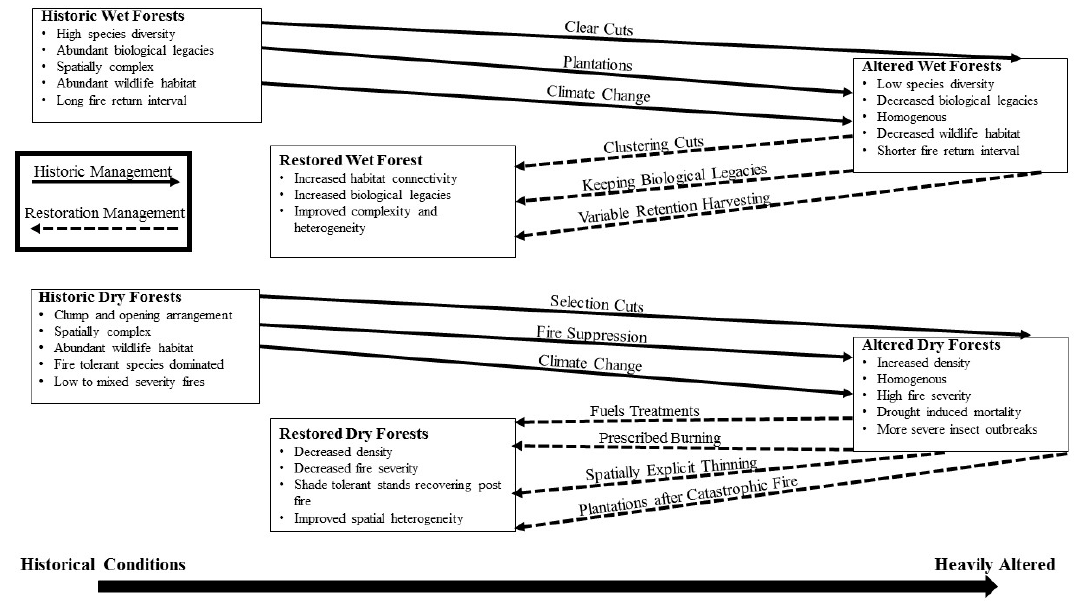
Figure 2. E ff ects of historic and restoration management on the wet and dry forests of the northwestern Figure 2. Effects of historic and restoration management on the wet and dry forests of the United States and northwestern United States and California.